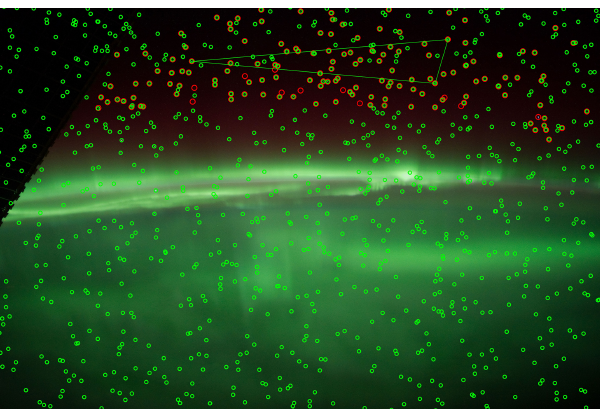
Figure 4. Results of applying astrometry.net to the image in Fig. 1. Green circles represent the locations of catalogue stars, red circles stars that have been detected in the image and identified. The tri- angle with three of the identified stars at its vertices shows one of the “Quads” used by astrometry.net to deduce the plate scale and orientation of the